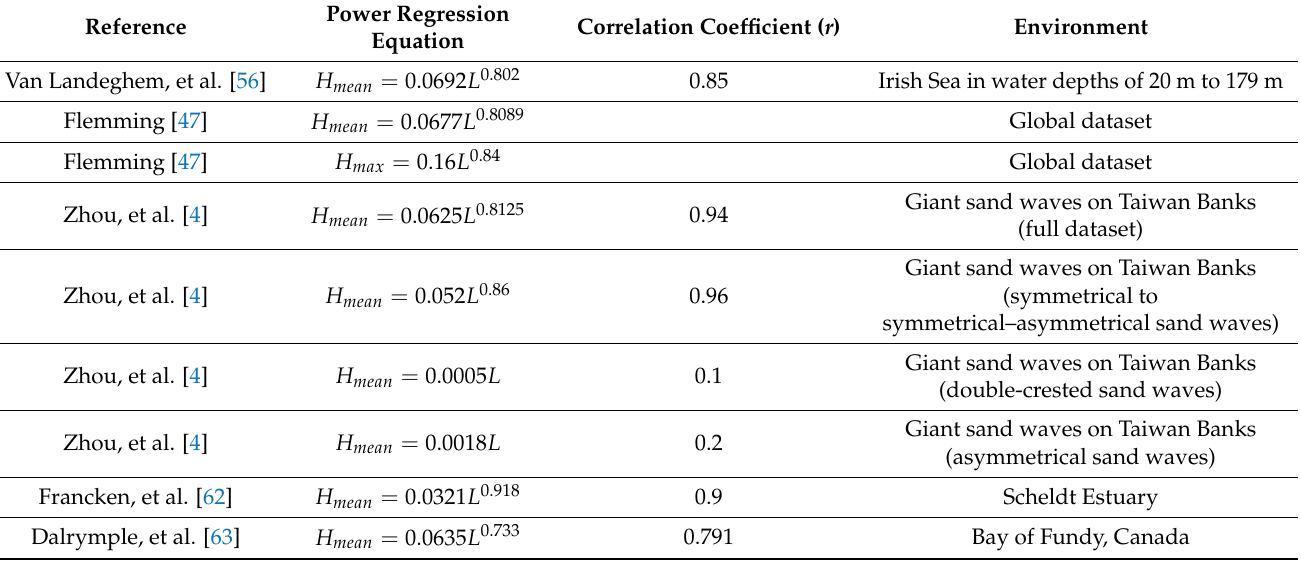
Table 1. Geometrical relationships of sediment waves from previous